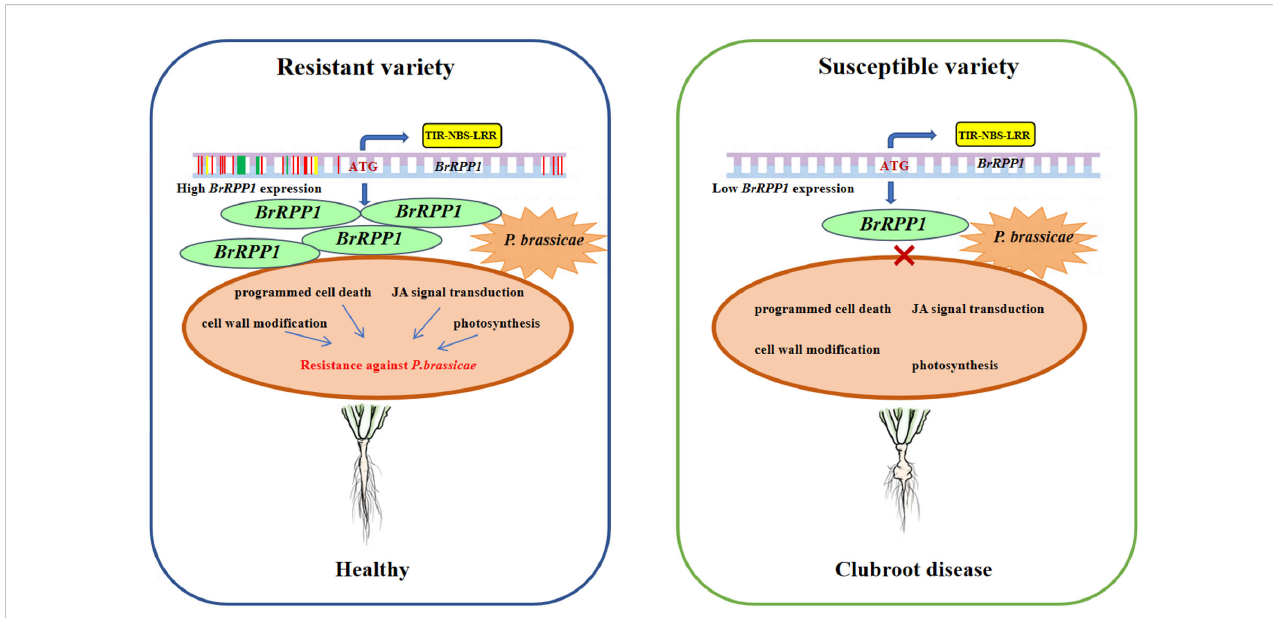
FIGURE 8 Role pattern of BrRPP1 in Chinese cabbage response to Plasmodiophora brassicae . BrRPP1 gene contains TIR-NBS-LRR domain and belongs to R gene. The gene sequence of BrRPP1 in resistant varieties was different from that in susceptible varieties. Green represents base insertion, yellow represents base deletion, and red represents base mutation. The difference of BrRPP1 promoter sequence leads to the signi fi cant difference of gene expression between resistant varieties and susceptible